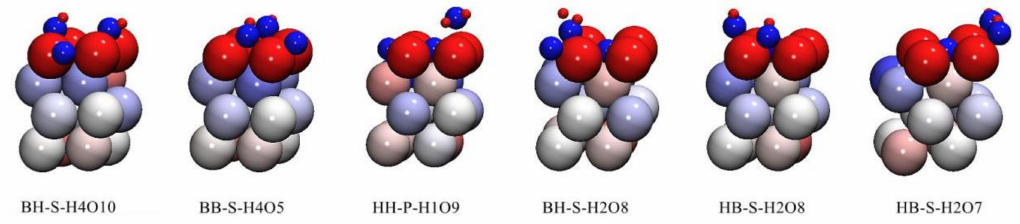
Figure 8. The atom charge of stable adsorption configuration obtained by preferential adsorption of H 2 O: red indicates positive charge, blue indicates negative charge and the charge range is − 0.30 e ~0.30 e .